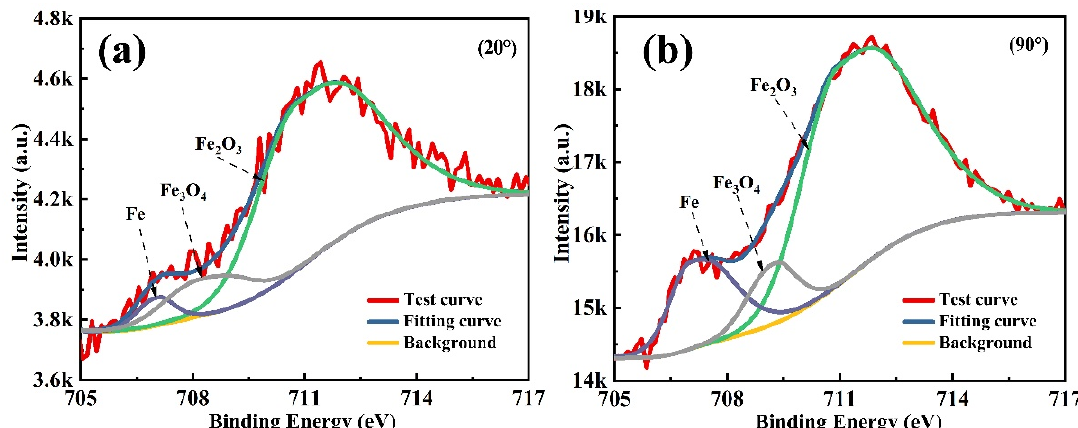
Figure 8. ARXPS spectra of Fe 2p photoemission and the peak fitting results for NiFe thin film with a thickness of 100 nm at different take-off angles of: ( a ) 20° and ( b ) 90°.